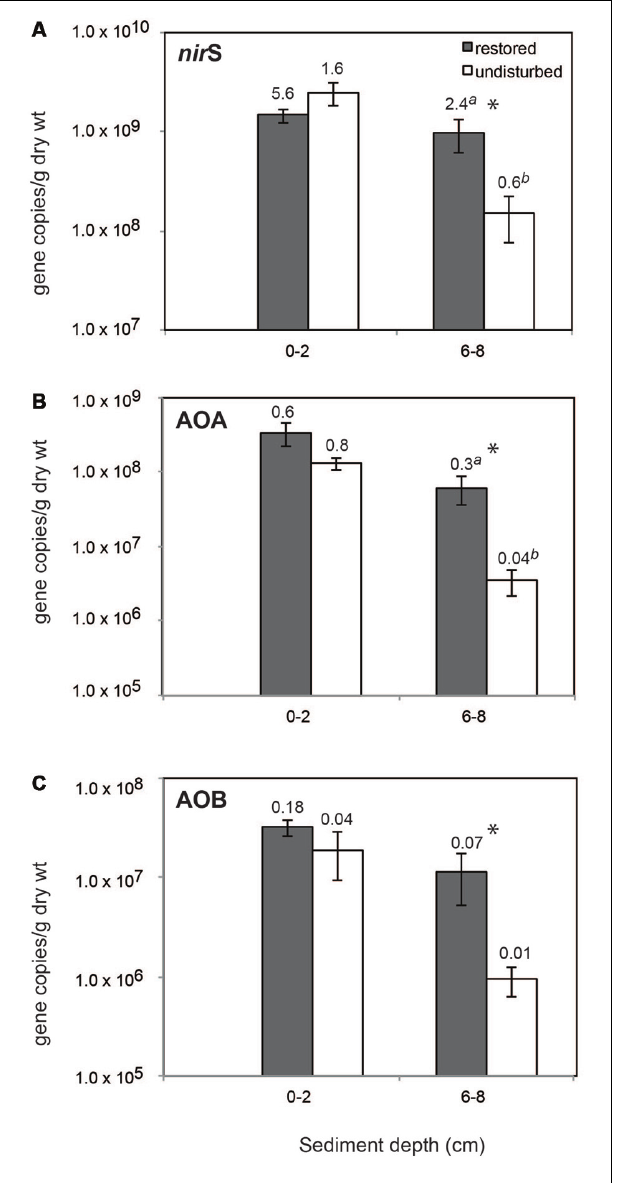
FIGURE 1 | Mean ( ± SE) abundance of nir S (A), archaeal amo A (B), and betaproteobacterial amo A (C) genes in sediment from restored and undisturbed marshes. Asterisks (*) indicate significantly different values ( P ≤ 0.05) between means ( n = 4) from restored and undisturbed marshes. Numbers above bars are the mean ratio of functional gene abundance to Bacterial 16S rRNA gene abundance. Significantly different ratios between restored and undisturbed sites are indicated by different